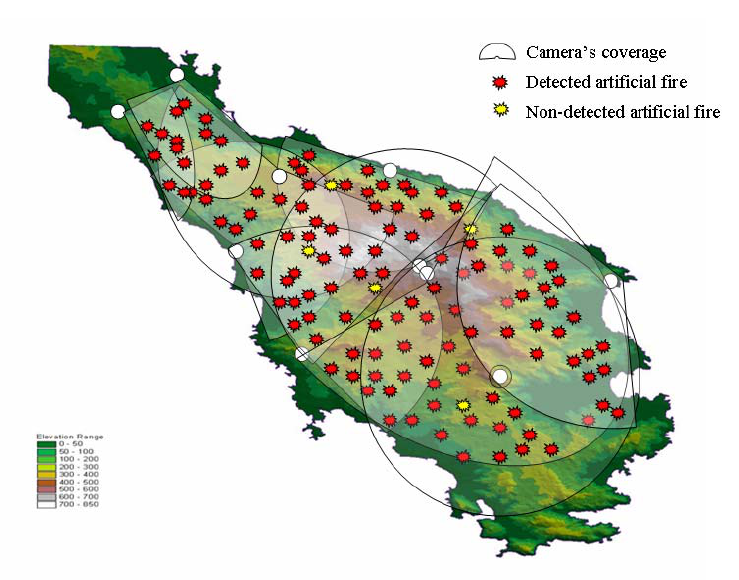
Figure 6. Cameras’ coverage and locations of artificial